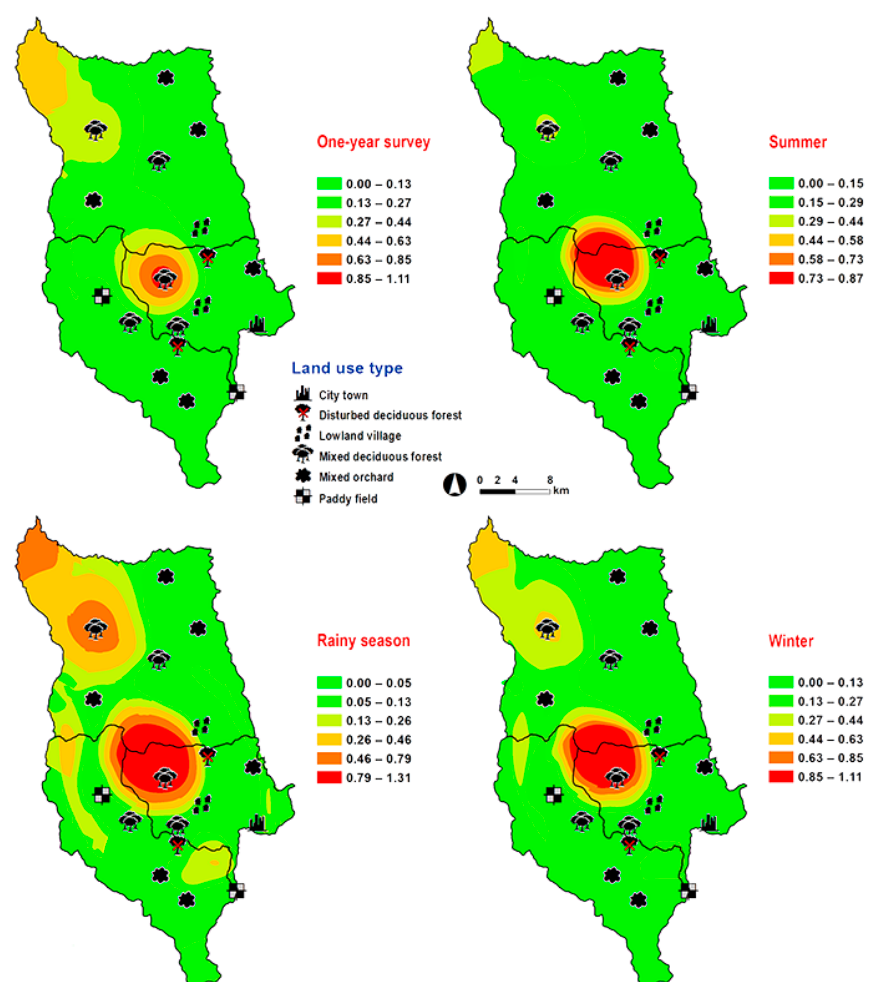
Figure 5. Predictive distribution maps of Lucilia porphyrina. The color scheme represented different fly density categories. The red areas represent the highest fly population, while the green represent the lowest population density. The scale corresponds to natural logarithm of (fly density + 1).